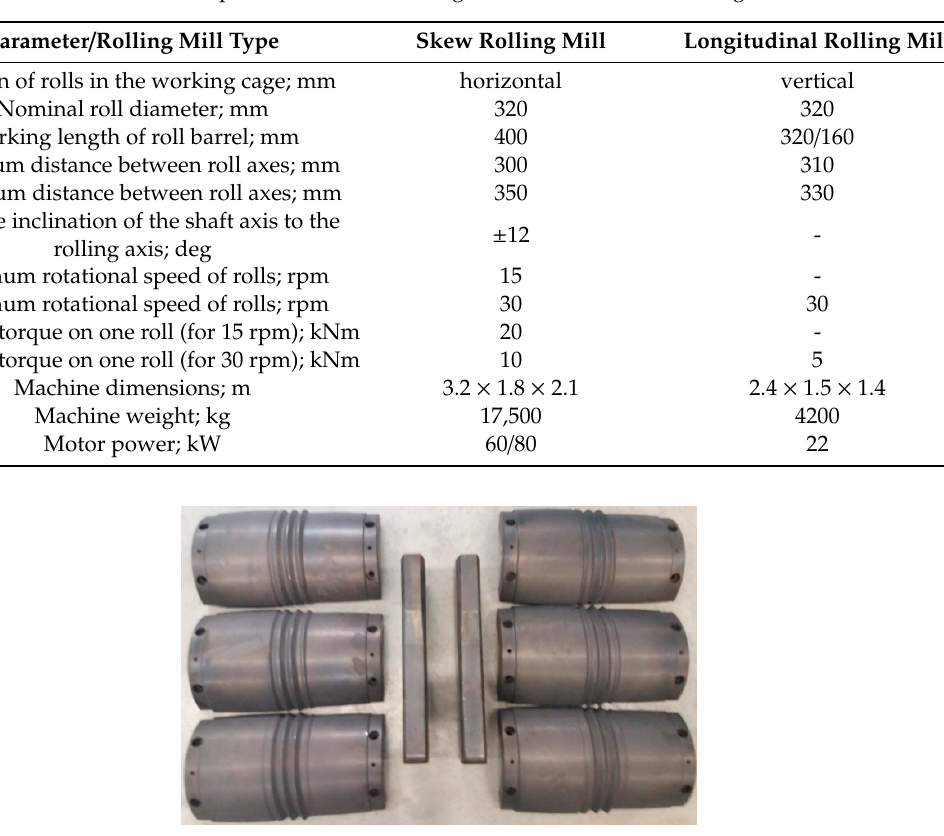
Table 2. Basic parameters of the rolling mills used in the rod rolling tests.